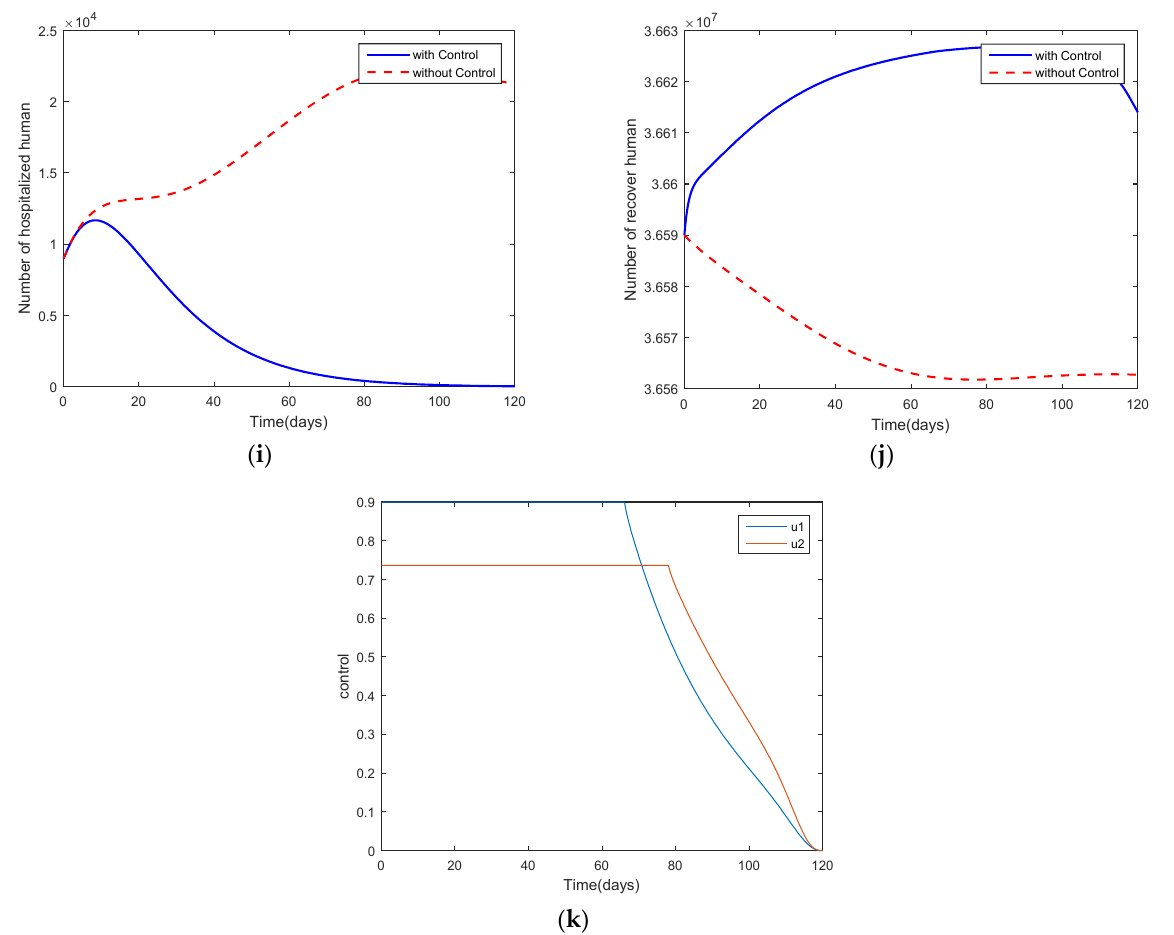
Figure 11. Comparison between the cases with control and the cases without control for the endemic: ( a ) the number in the unvaccinated, susceptible population; ( b ) the number in the unvaccinated, exposed population; ( c ) the number in the unvaccinated, asymptomatic, infected population; ( d ) the number in the unvaccinated, symptomatic, infected population; ( e ) the number in the vaccinated, susceptible population; ( f ) the number in the vaccinated, exposed population; ( g ) the number in the vaccinated, asymptomatic, infected population; ( h ) the number in the vaccinated, symptomatic, infected population; ( i ) the number in the hospitalized population; ( j ) the number in the recovered population; and ( k ) control efforts u 1 ( t ) and u 2 ( t )